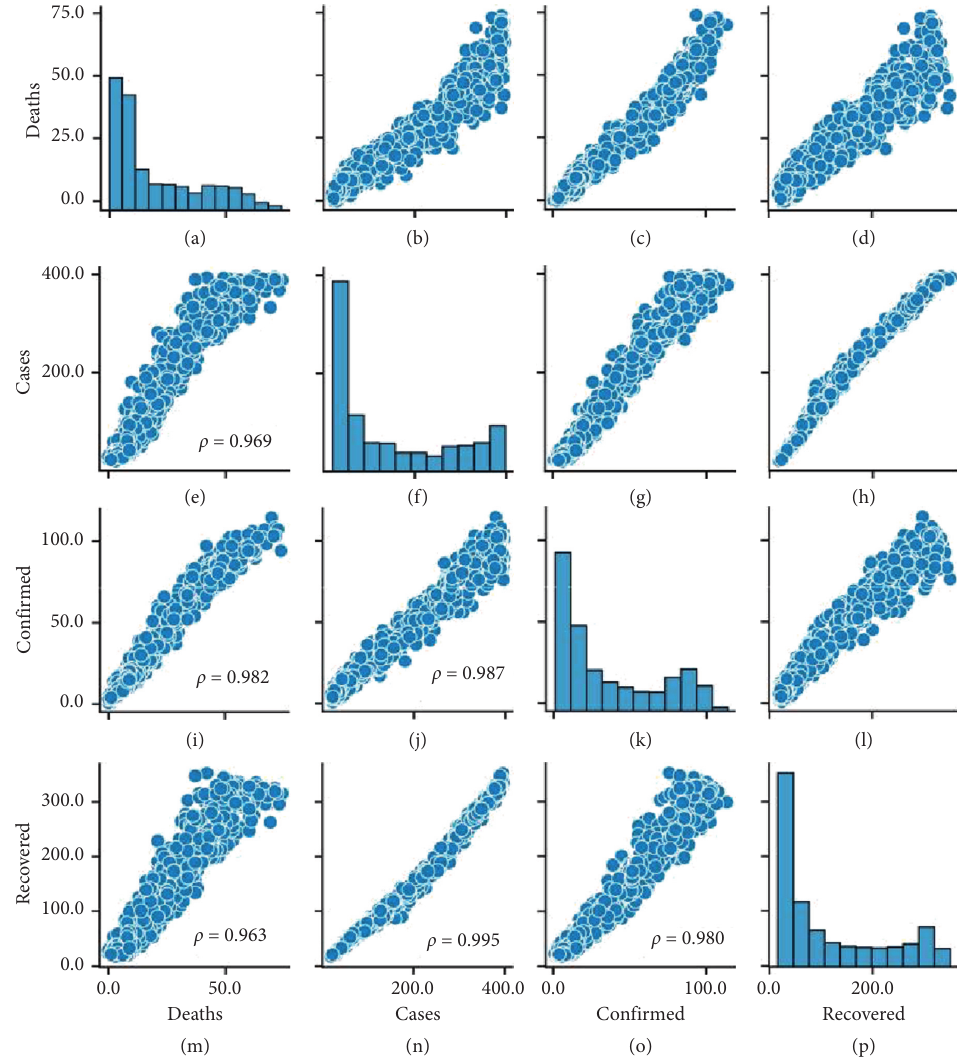
Figure 8: Pairwise correlations and frequency distribution of output variables, reported with p < 0 .